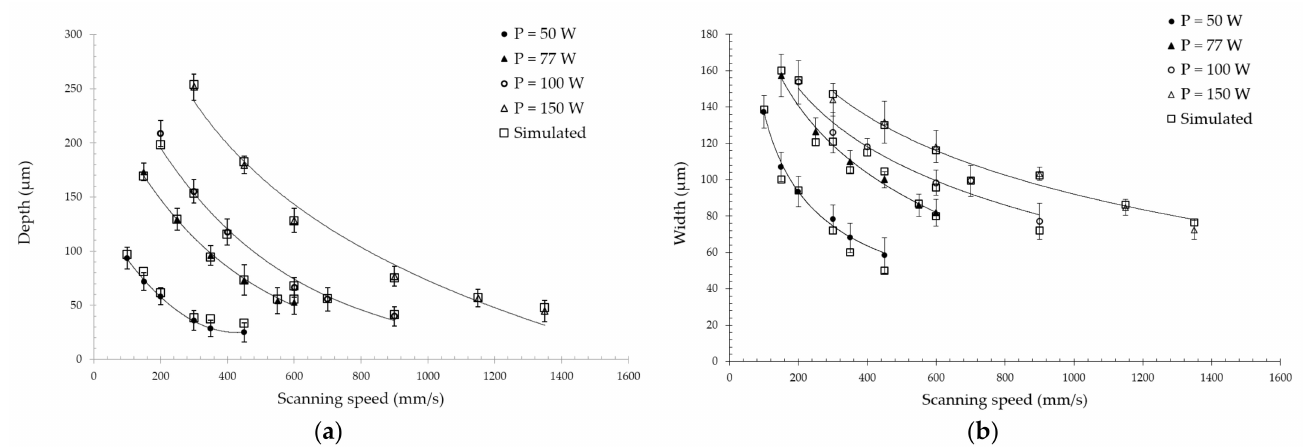
Figure 11. Experimental and simulated results on the ( a ) depth and ( b ) width of the melt